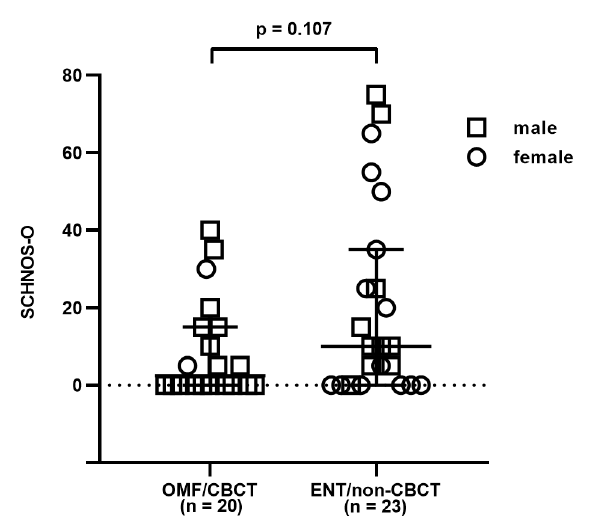
Figure 3. Comparison of SCHNOS-O score between patients of the OMF/ CBCT group and patients of the ENT/non-CBCT